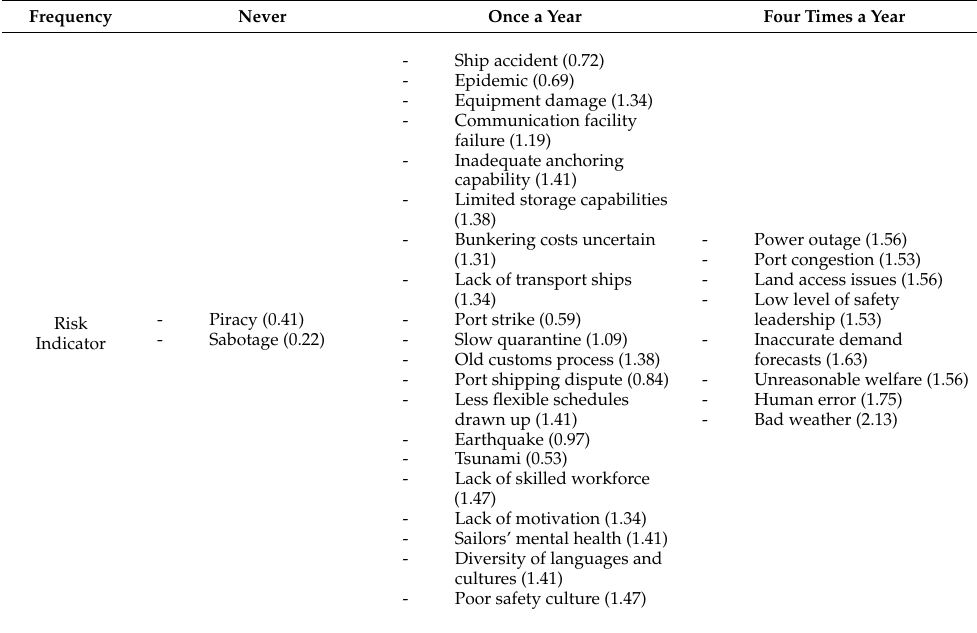
Table 4. Frequency of risk events in SS-LNG in